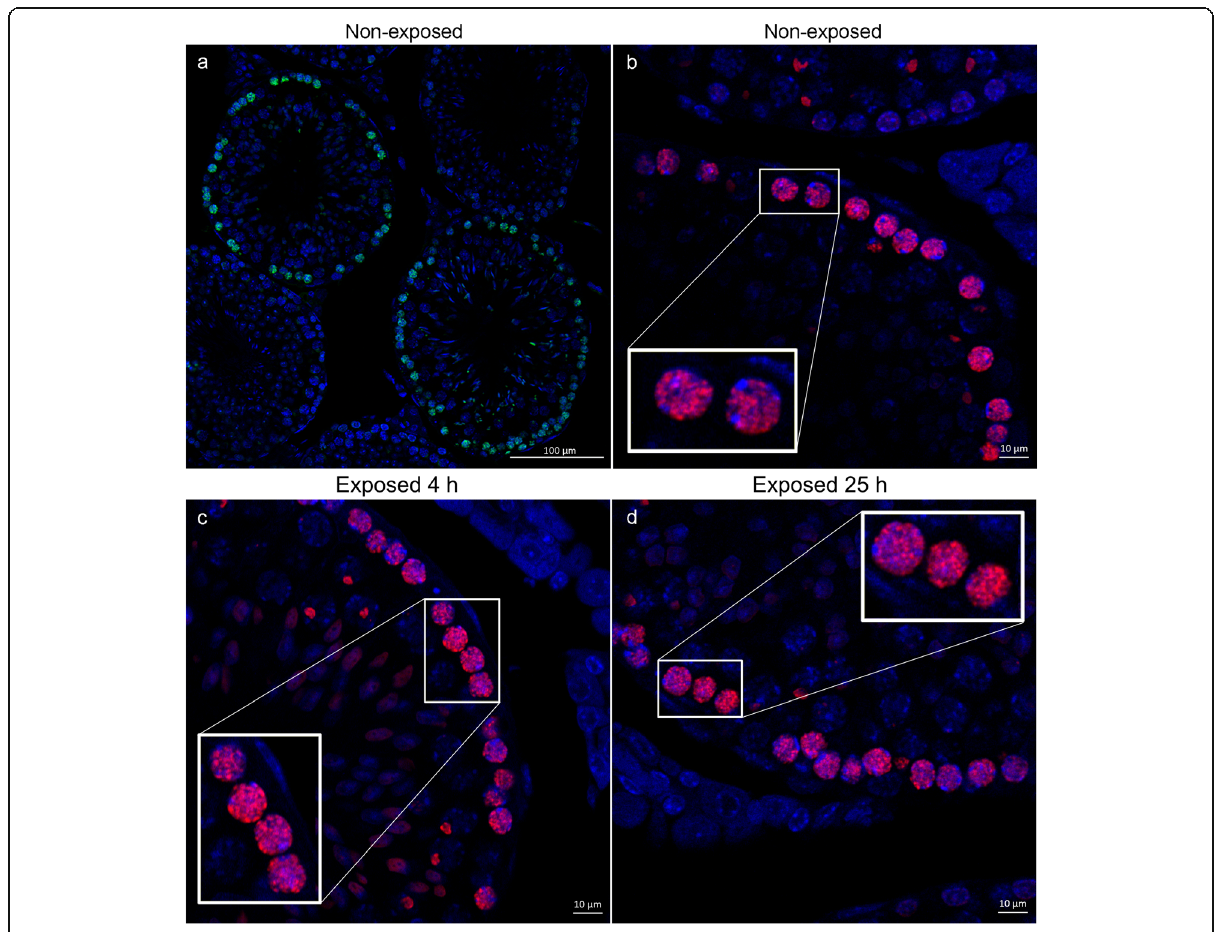
Fig. 1 Confocal laser microscopy of testis sections. Representative images of one optical section of a , b non-exposed animals, c animal 4 h P.I., and d animal 25 h P.I. The low-magnification image in a illustrates the distribution of γ -H2AX labeling (green, visualized with anti-mouse AF488 conjugated secondary antibodies) and images b – d illustrate in higher magnification the γ -H2AX labeling (red, visualized with the anti-rabbit AF568 conjugated secondary antibodies). Images were adjusted for brightness and contrast. Scale bars in a 100 μ m and in b – d 10 μ